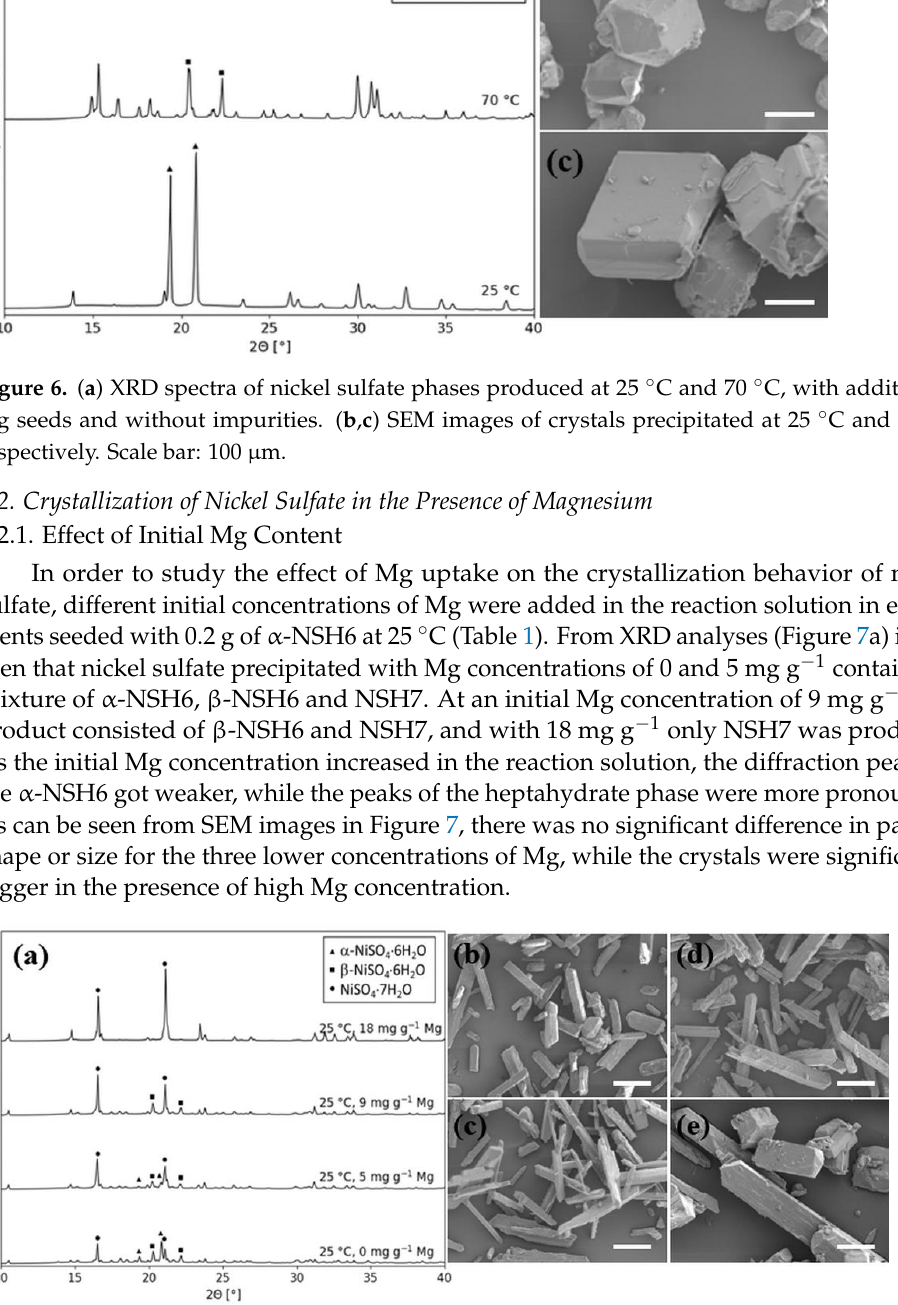
Figure 7. ( a ) XRD spectra of nickel sulfate phases precipitated with 0. 2 g α -NSH6 seeds at 25 °C in the absence and presence of Mg at indicated concentration levels. SEM images of crys- tals collected from corresponding experiments; ( b ) no magnesium, ( c ) 5 mg g −1 Mg, ( d ) 9 mg g −1 Mg, and ( e ) 18 mg g −1 Mg. Scale bar: 100 µm.